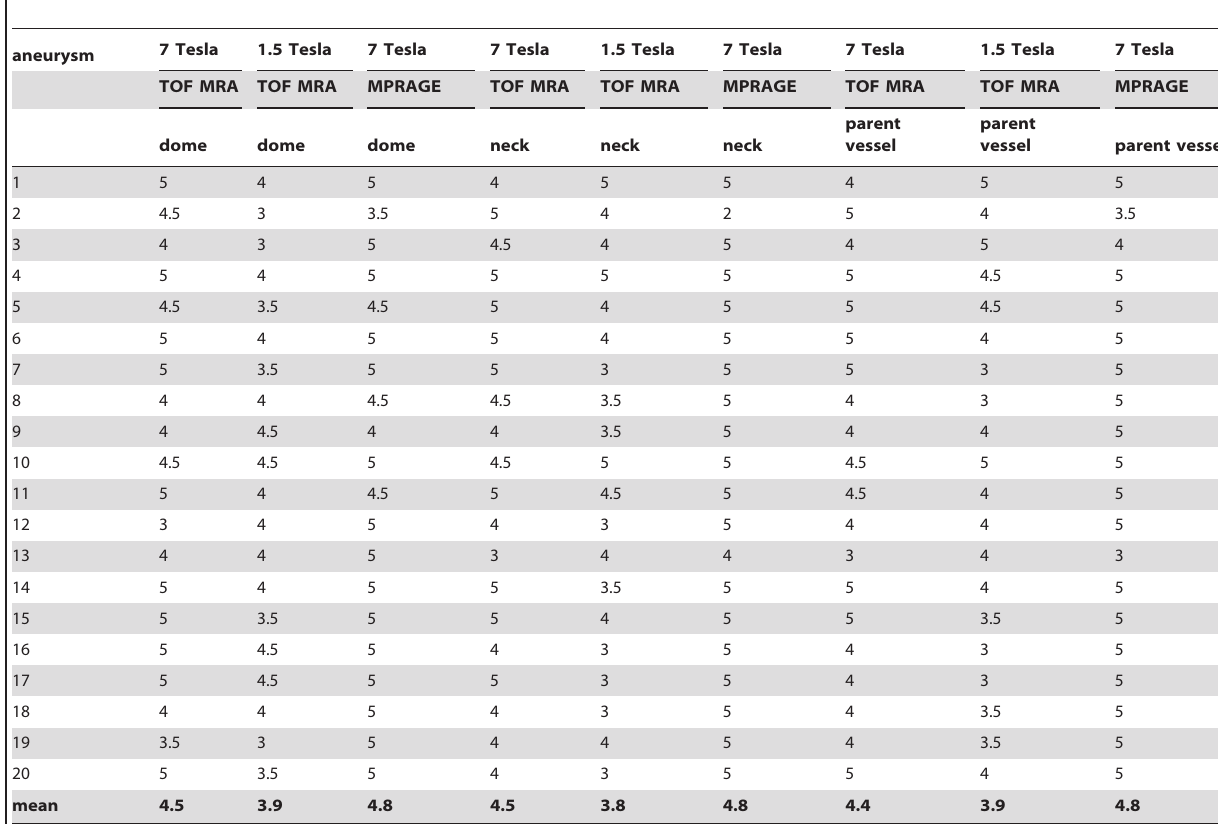
Table 3. Ratings for dome, neck and parent vessel delineation (mean ratings from both readers).